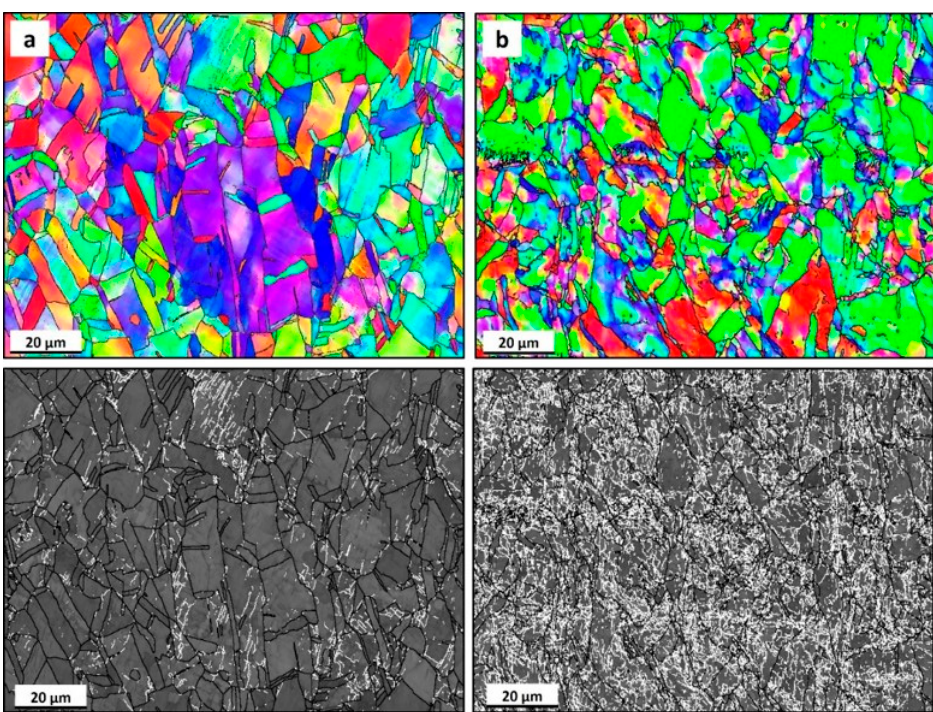
Figure 7. IPF coloring maps relative to ND and their corresponding band contrast maps with the angle boundaries superimposed for the commercial pure Cu ECAP processed at RT for ( a ) 2-P and ( b ) 4-Bc. Step size used in EBSD data collection was 0.2 µm in all cases (for interpretation of the references to color in this figure legend, the reader is referred to the web version of the article).